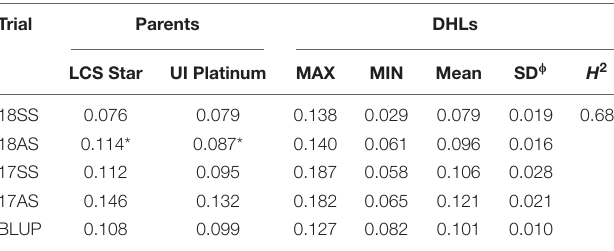
TABLE 2 | Phenotypic performance and distribution of Cd content (mg kg − 1 ) in parents and the doubled haploid lines in four-field trials.